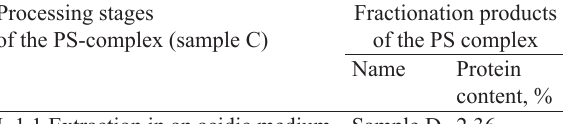
Table 2 Fractionation of the PS-complex and characteristics of the products obtained Processing stages of the PS-complex (sample C)